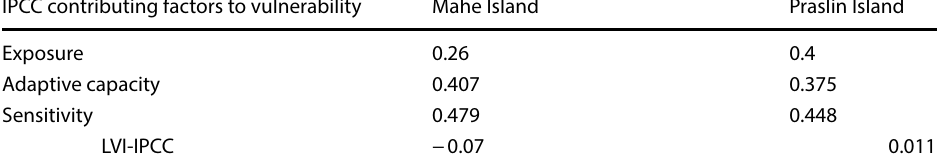
Table 6 LVI–IPCC contributing factors calculation for Mahe and Praslin Islands, Seychelles